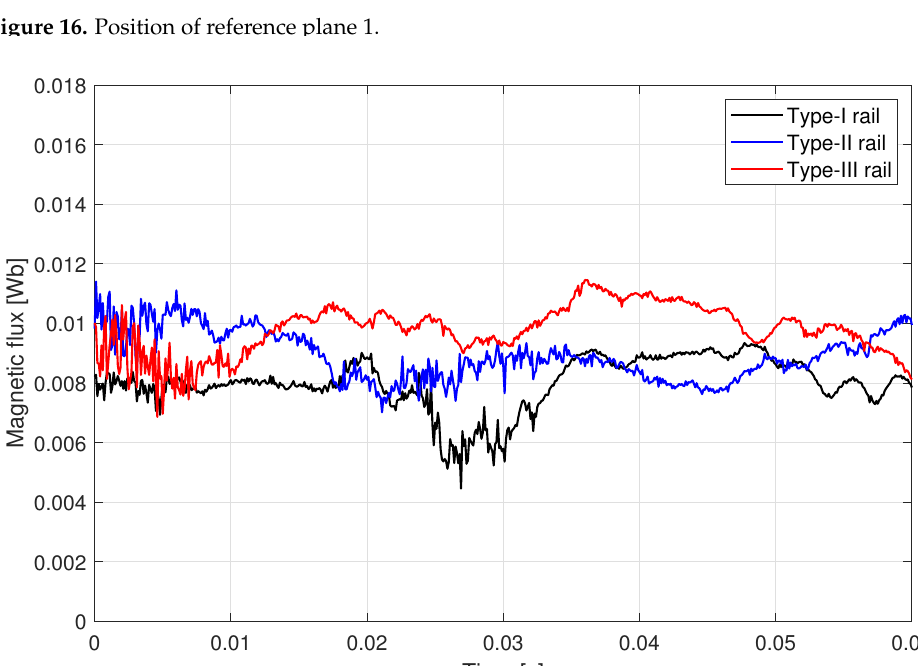
Figure 17. Integral of B Z along reference plane